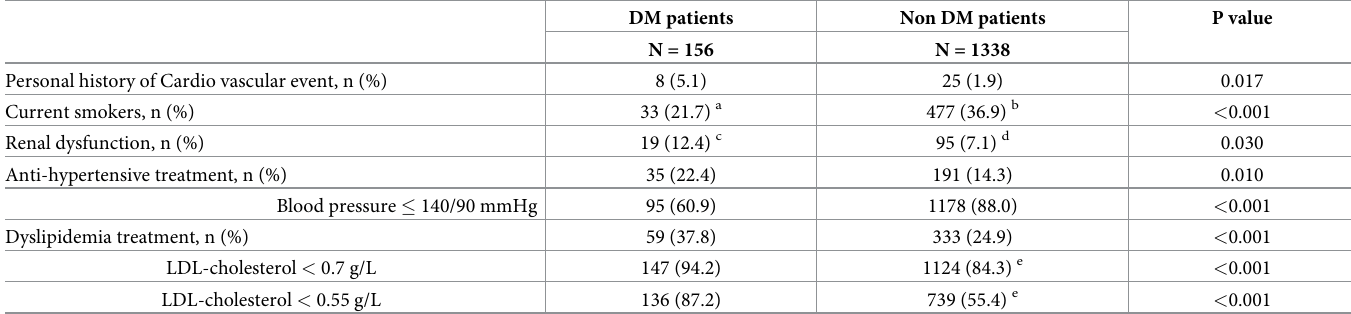
Table 2. Cardiometabolic comorbidities in the OVIHD cohort.